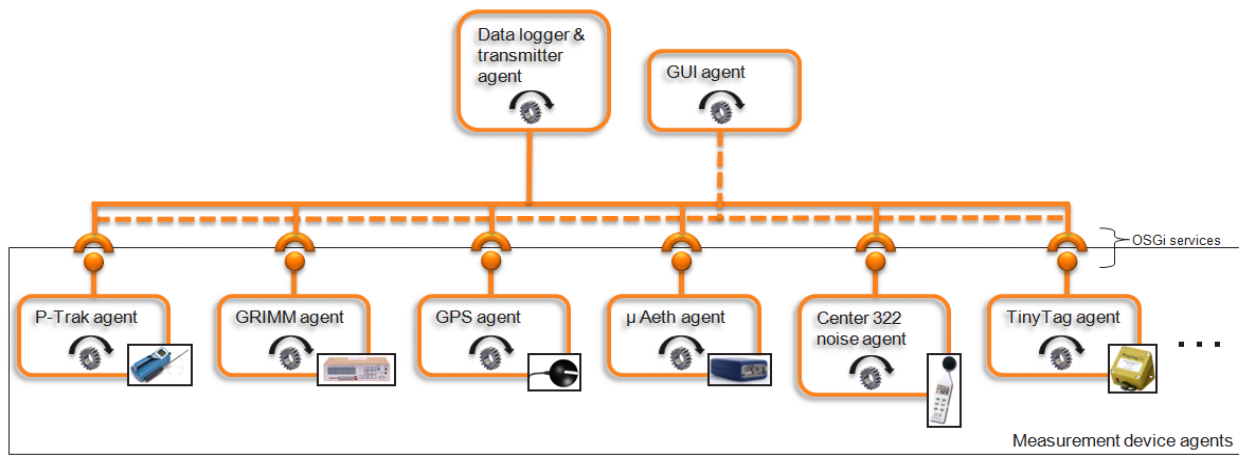
Figure 2. Aeroflex adaptable software architecture with autonomously operating software